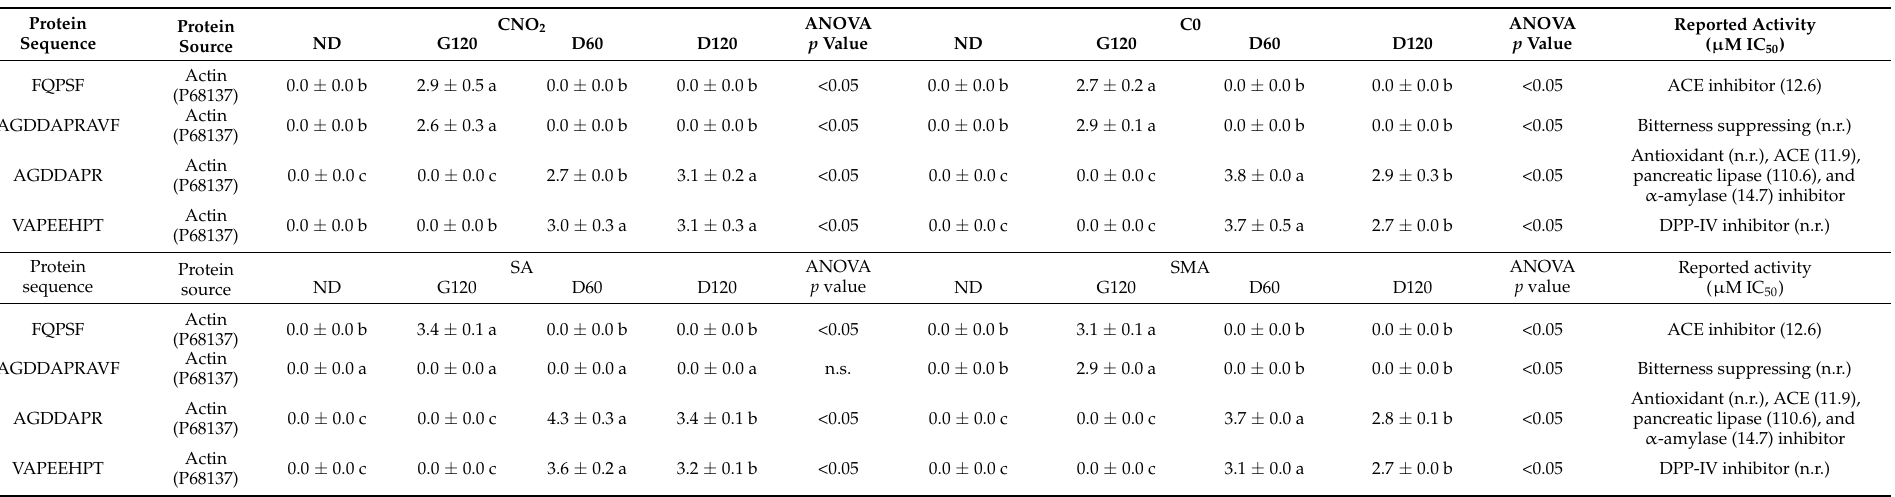
Table 3. Relative bioactive peptide abundance in non-digested and digested salami at different digestion time points. Data are means ± SD of non-digested or in vitro digestion of three independent samples analyzed in duplicate. Statistical analysis was performed by a one-way ANOVA with Tukey’s post-hoc test comparing each salami before digestion and at the three digestion time points (different letters indicate significant differences). G120: end of gastric phase; D60: 60 min of duodenal phase; D120: end of duodenal phase ND: not digested; DPP-IV: dipeptidyl peptidase 4; ACE: angiotensin-converting enzyme; n.r.: not reported; C-NO 2 : salami with sodium nitrite, potassium nitrate and with nitrate-reducing microbial starter cultures; C-0: salami containing neither nitrate-reducing microbial starter cultures nor additives (nitrite, polyphenols and ascorbate); SA: salami with nitrate-reducing microbial starter cultures and sodium ascorbate; SMA: salami with nitrate-reducing microbial starter cultures, sodium ascorbate and plant